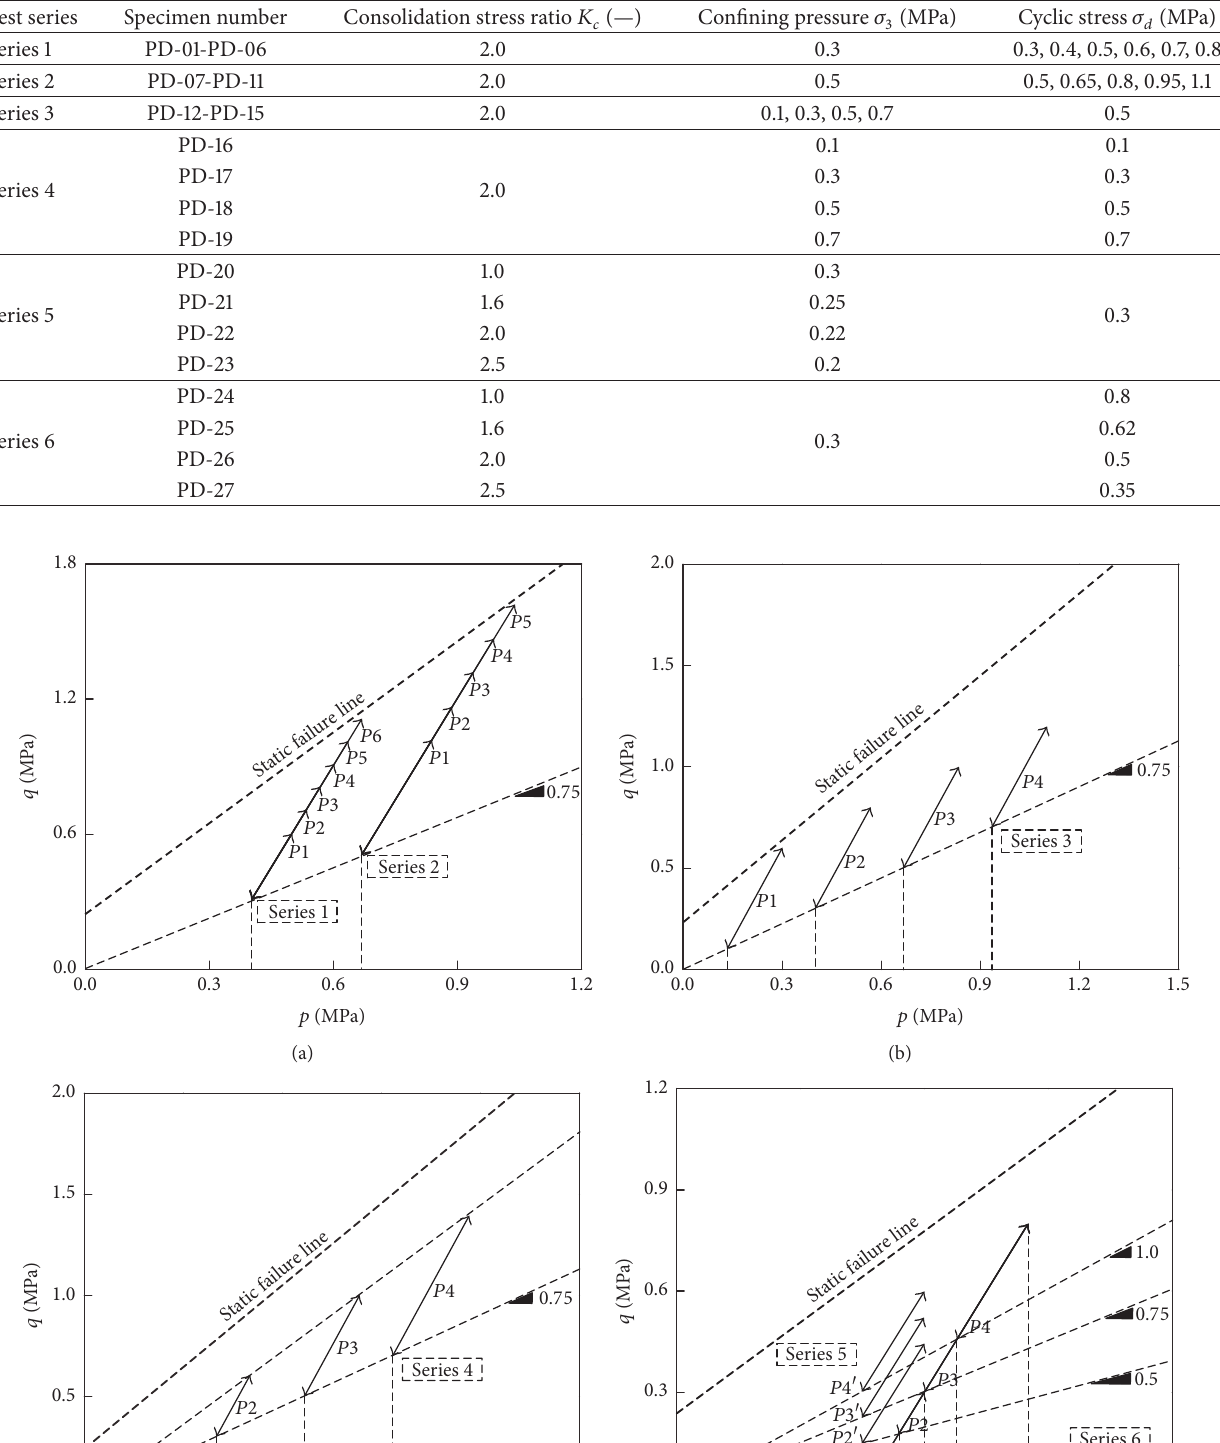
Table 1: Summary of test loading program.